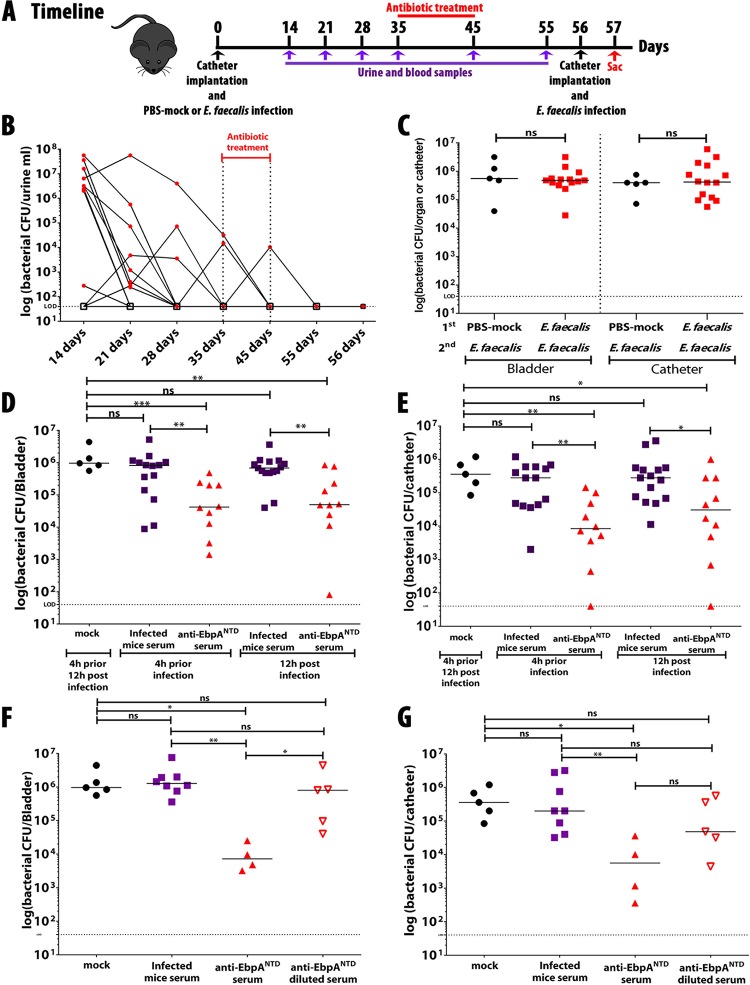
A prior enterococcal infection does not confer protection against a subsequent infection. (A and B) Mice were mock infected (n = 5) or infected with E. faecalis OG1RF (n = 15) (A); infection was followed by measuring the bacterial burden in urine (B). (C) After antibiotic treatment, mice were infected and bacterial burdens in bladder tissue or recovered catheters were quantitated as the number of CFU recovered. (D to G) Mice were immunized with mock serum (n = 5), serum from infected mice (n = 15 [D and E] or n = 10 [F and G]), anti-EbpANTD antibodies (n = 15 [D and E] or n = 5 [F and G]), or diluted anti-EbpANTD antibodies (n = 5). Following 24 h of infection, bladders (D and F) and catheters (E and G) were harvested and bacterial burdens were quantified. Values represent means ± SEM. The Mann-Whitney U test was used; P < 0.05 was considered statistically significant. *, P < 0.05; **, P < 0.005; ***, P < 0.0005; ns, values were not statistically significantly different. The horizontal bar represents the median value. The horizontal broken line represents the limit of detection of viable bacteria. Animals that lost the catheter were not included in this work.